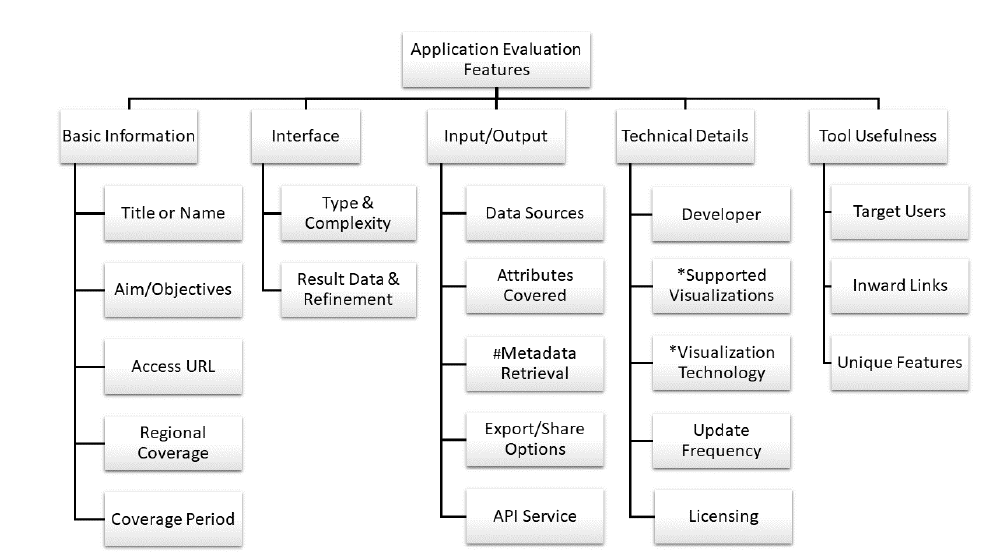
Figure 2. Selected features for evaluation of Web applications: portals, dashboards, and epidemiological models (* applies only to dashboards, # does not apply to dashboards and epidemiological